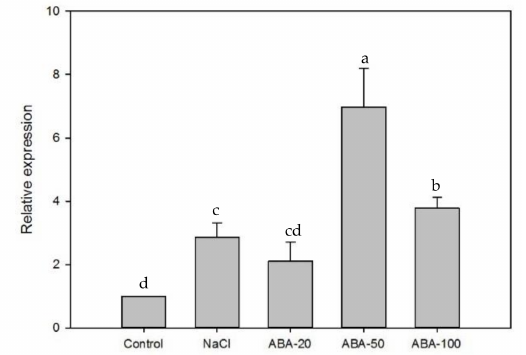
Figure 6. EsABI5 expression under different treatments in leaves. Different letters indicate significant differences compared to the control group ( p < 0.05). ABA-20 indicates that the concentration of exogenous ABA is 20 µ mol/L. ABA-50 indicates that the concentration of exogenous ABA is 50 µ mol/L. ABA-100 indicates that the concentration of exogenous ABA is 100 µ